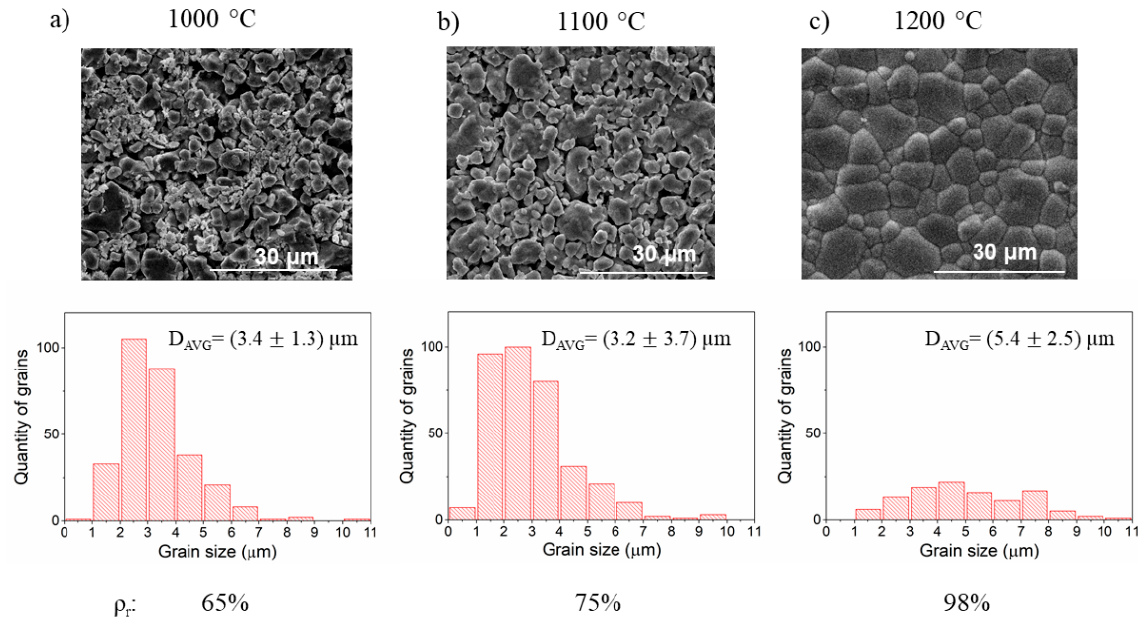
Figure 7. The SEM images, grain size distribution, and relative density ρ r of ceramics annealed at ( a ) 1000 °C, ( b ) 1100 °C, and ( c ) 1200 °C.